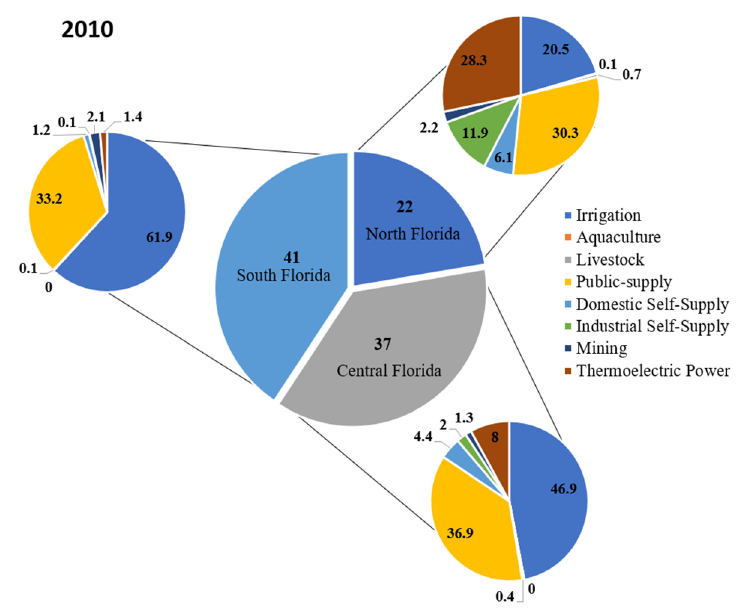
Figure 6. Florida water use in 2010.